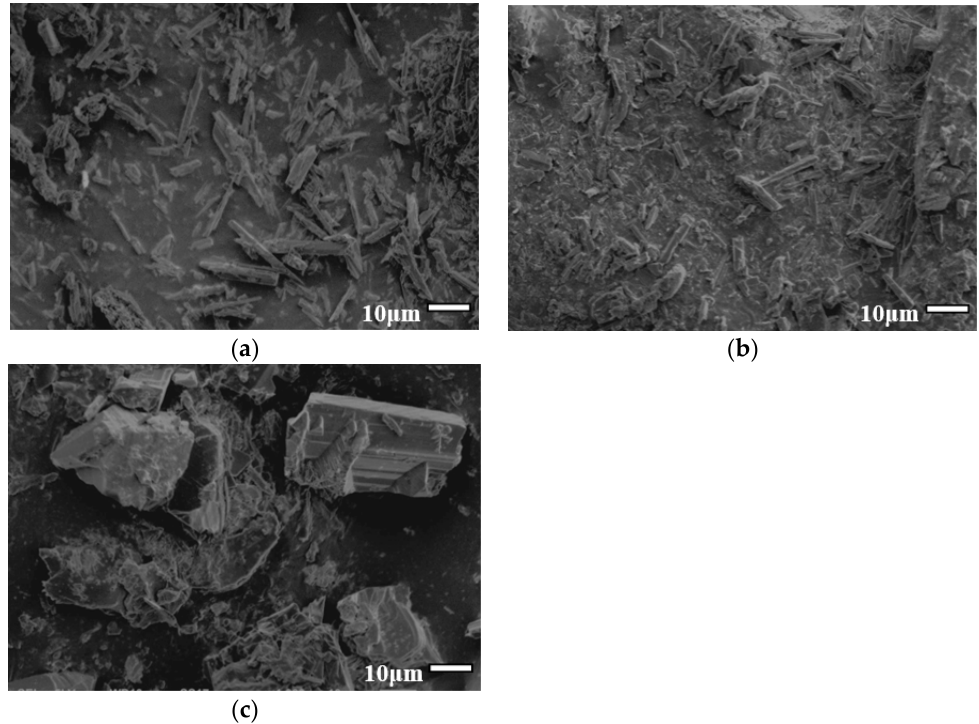
Figure 6. Morphology of CaSO 4 crystals obtained from blank solution ( a ), solution with 10 mg / L ( b ) and 15 mg / L ( c ) PEDTA-DEA. All of the solutions are heated to 80 ◦ C and kept for 10 h. Most of the CaSO 4 precipitation particles without polymer inhibitor are slim and